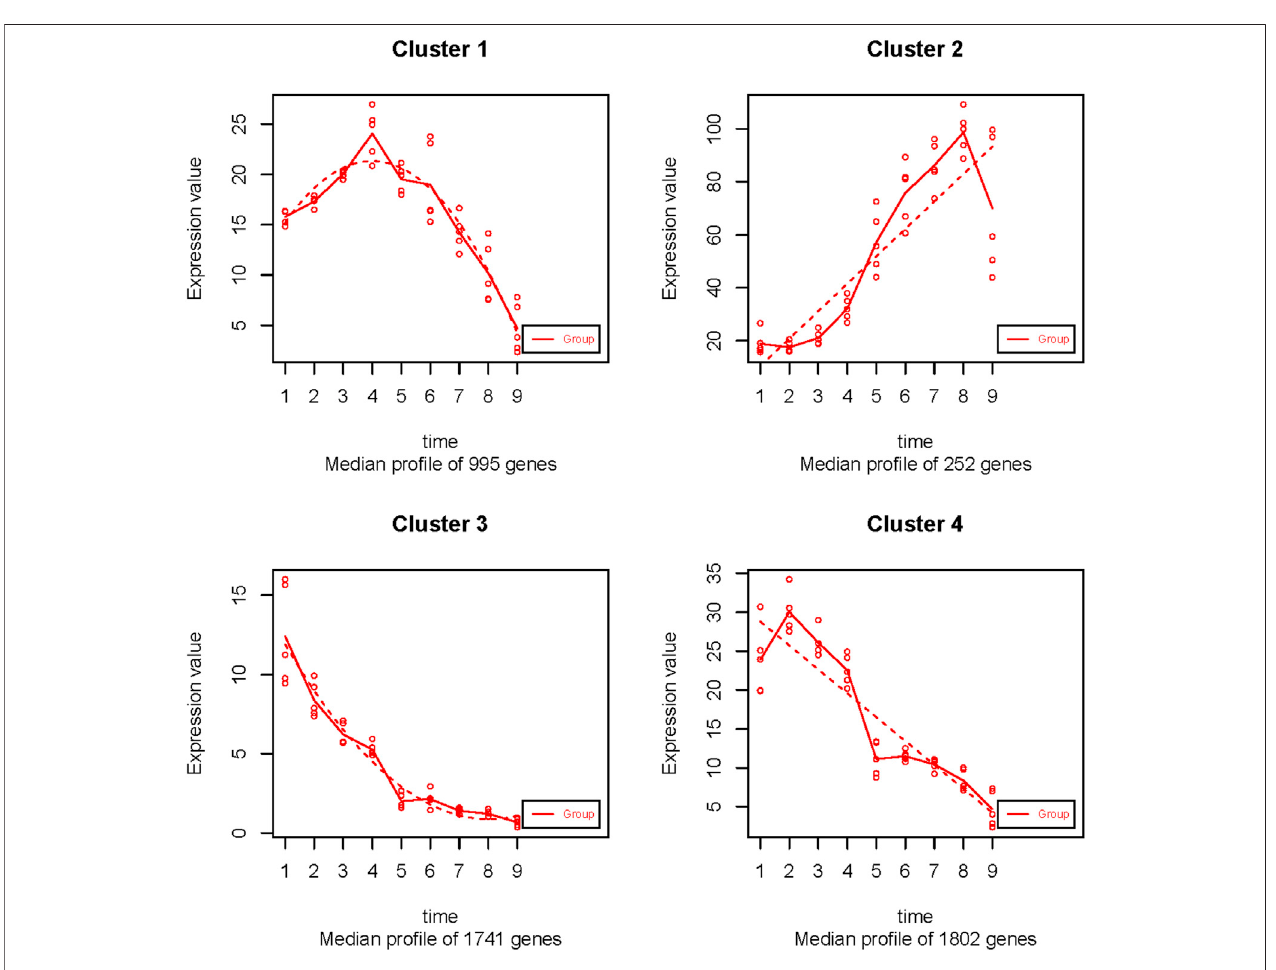
FIGURE 4 | The 4 temporal gene expression pro fi